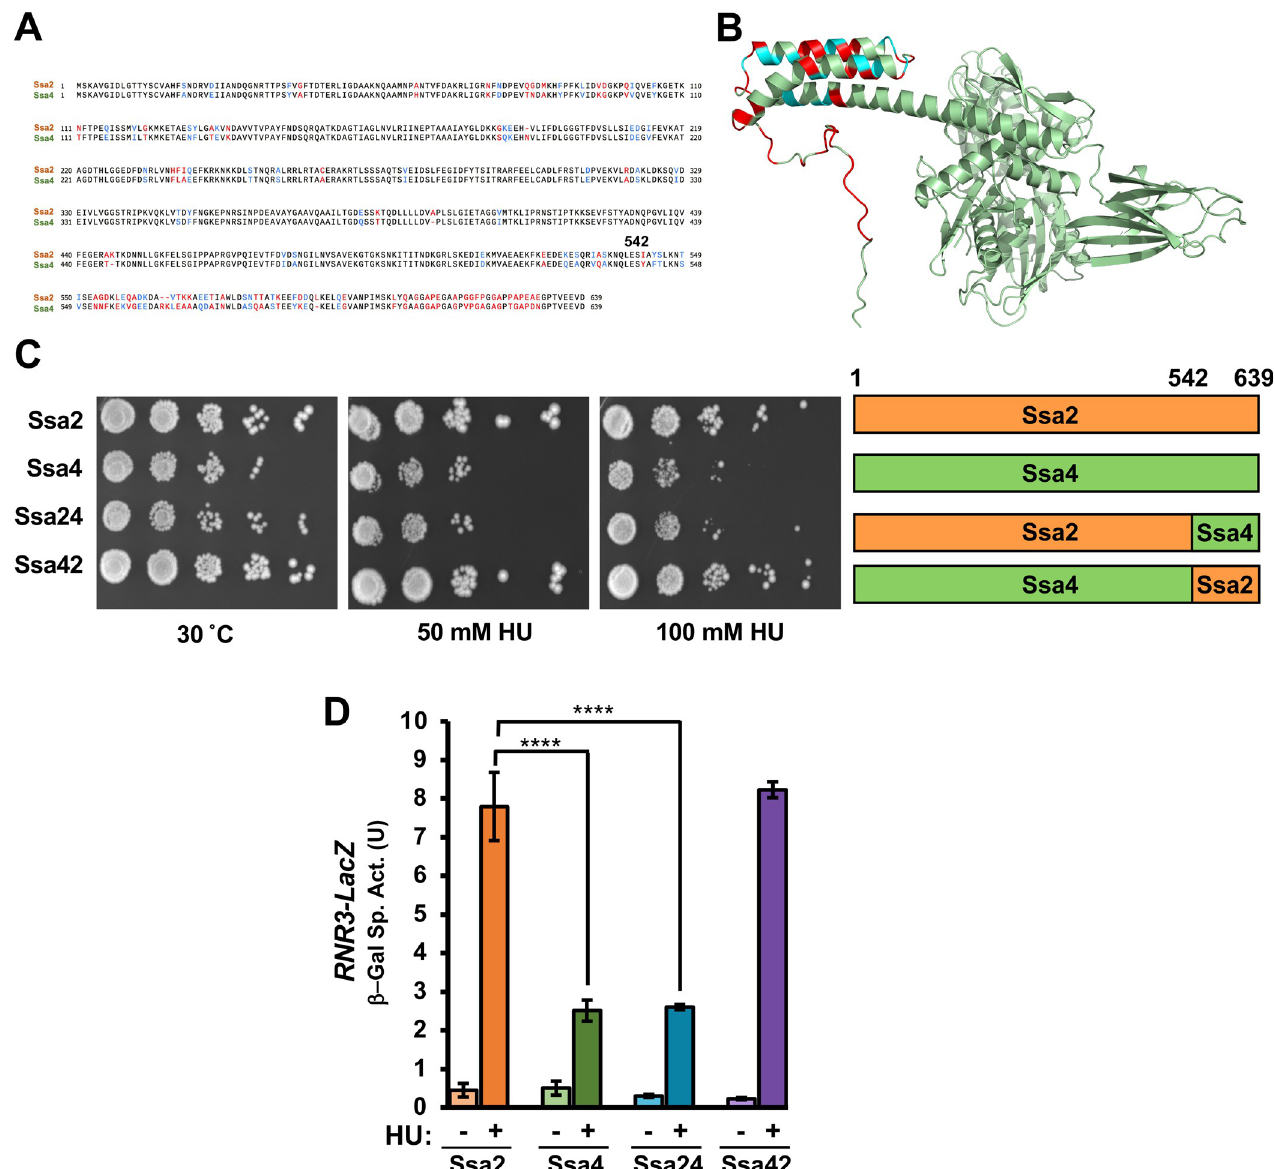
Fig 6. The C-terminus of Ssa2 is required for HU resistance. (A) Sequence alignment between Ssa2 and Ssa4 was created using Clustal Omega. Amino acids are labeled either Black (identical), Blue (similar) or Red (different). (B) Areas of sequence variance between Ssa2 and Ssa4 mapped to the predicted structure for Ssa2. The structure of Ssa2 was modeled via AlphaFold and rendered in PyMol. Residue similarity between Ssa2 and 4 was denoted by color (green, identical; blue similar; red, different). (C) Chimeras of Ssa2 and Ssa4 display altered resistance to hydroxyurea. Cells expressing either Ssa2, 4, 24 or 42 as the sole Ssa were grown overnight to saturation and serial 10-fold dilutions were plated by pin plating from 96-well plates onto YPD alone or YPD containing Hydroxyurea. Plates were imaged after 3 days. (D) DNA-damage response transcription in Ssa2-4 chimeras. An RNR3-LacZ reporter plasmid was transformed into the indicated yeast strains. Transformants were grown and subjected to 0 or 200mM HU for 3 hours. β -Galactosidase activity was measured in crude extracts. β -Galactosidase specific activity (in units) [-Gal Sp. Act. (U)] is shown on the y axis. Each value represents the mean and standard deviation (error bar) from three independent transformants; P � 0.05 �� , P � 0.01; ��� , P � 0.001; ���� , P � 0.0001 compared to indicated